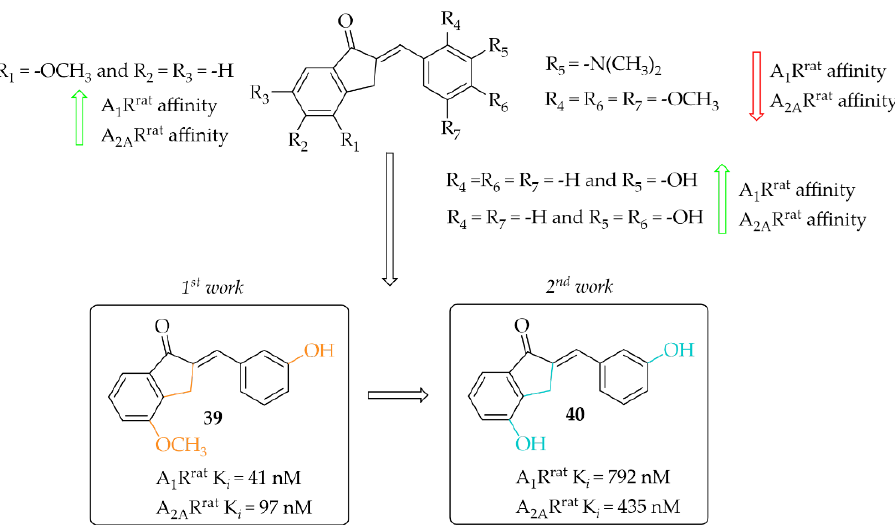
Figure 30. 2-Benzylidene-1-indanone as adenosine A 1 and A 2A receptor ligands and the most potent compounds in this series [68,69].